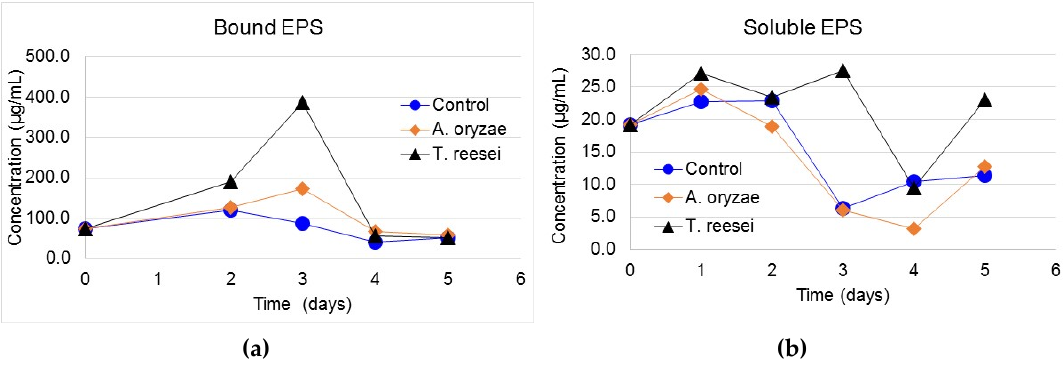
Figure 3. Protein content in bound and soluble EPS. ( a ) Bound EPS; ( b ) Soluble EPS.